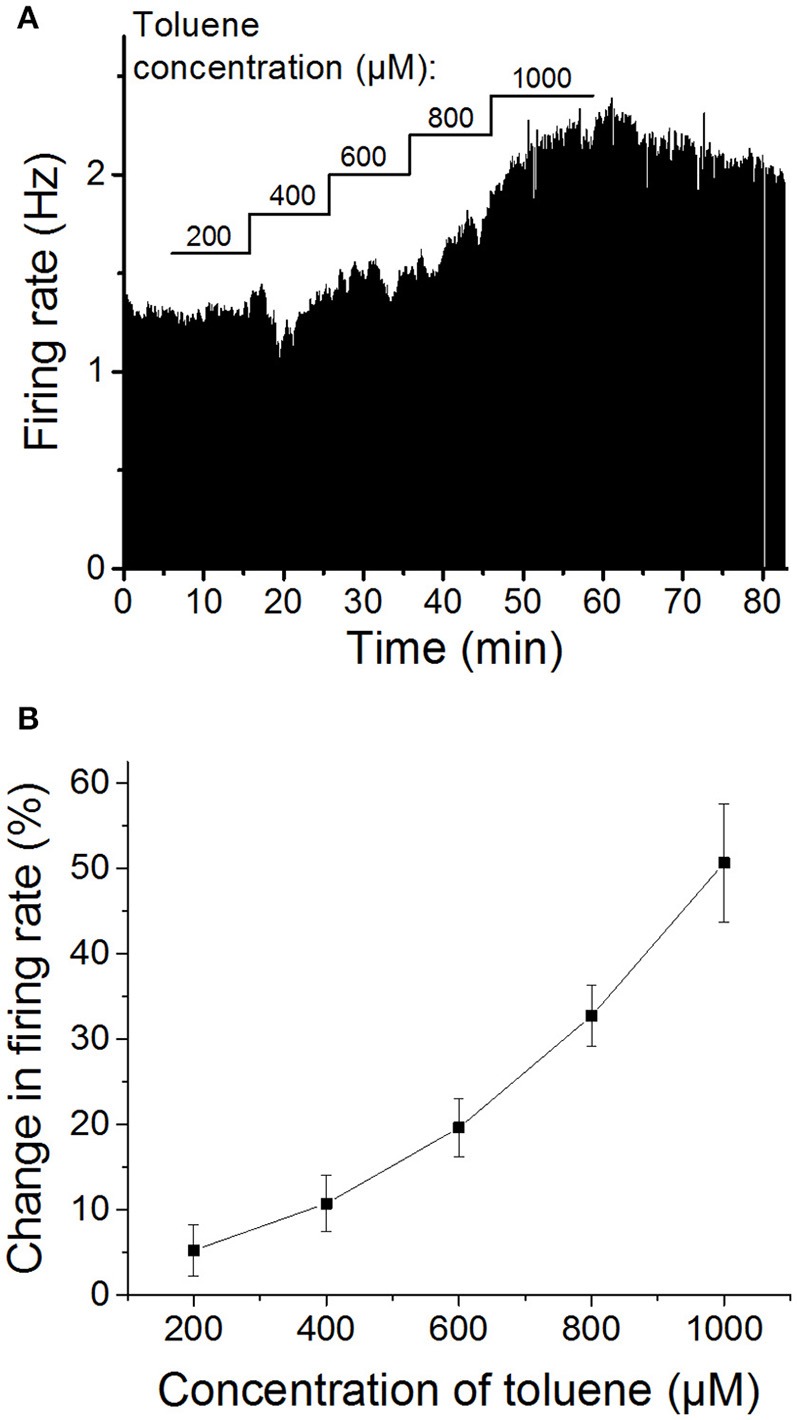
Concentration-dependent excitation of DA VTA neurons by toluene. (A) Ratemeter graph of firing rate over time recorded from a single VTA neuron. Vertical bars indicate firing rate over a 5 s interval; horizontal bars indicate the duration of administration of toluene (concentration indicated above bar). Toluene produced increases in firing (in Hz) of 200 μM: 1.01; 400 μM: 7.35; 600 μM: 15.87; 800 μM: 38.16; 1000 μM: 66.33. (B) Pooled concentration-response curve of the effect of toluene on spontaneous activity of DA VTA neurons. Toluene was added to the superfusate and concentrations were increased in a step-wise manner (10 min per step) from 200 to 1000 μM in 200 μM steps. (These same data are shown in Figure 4A below as control).